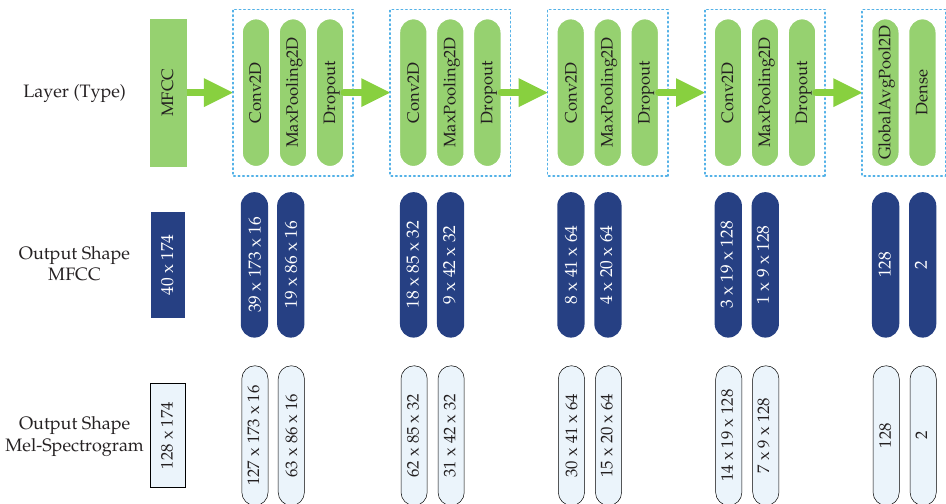
Figure 6. CNN architecture used in classification of gunshot sounds for both MFCC and Mel-spectrogram features.